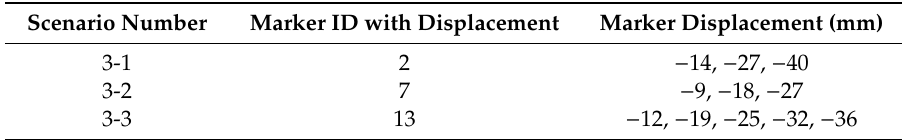
Table 4. Marker ID with displacement and corresponding displacement values in Scenarios 3-1, 3-2, and